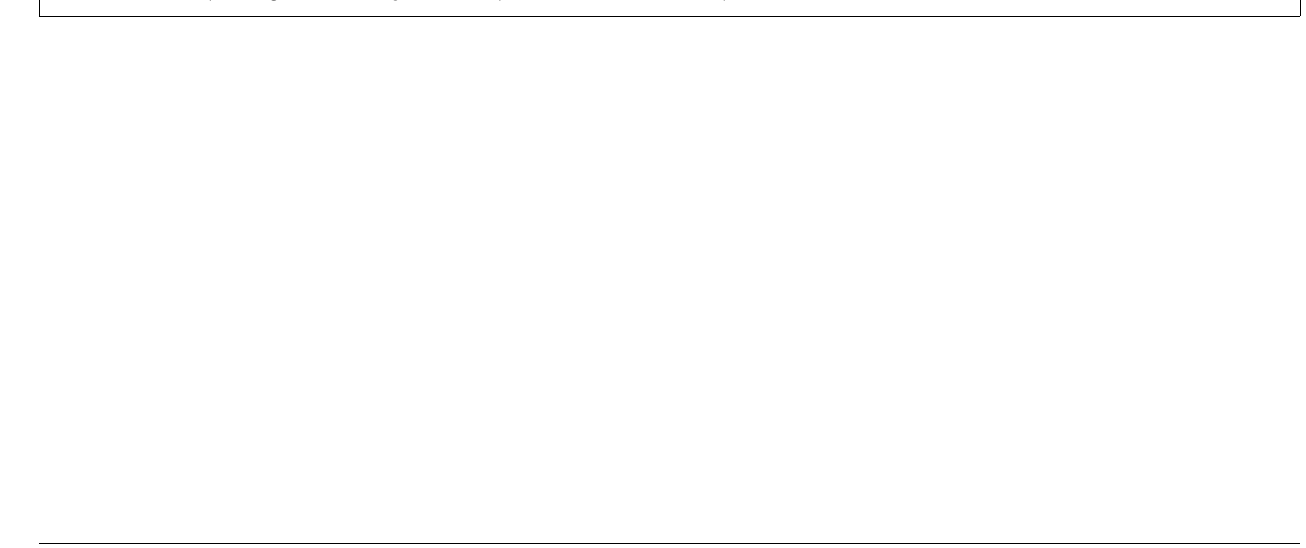
Frontiers in Psychology | Cognitive